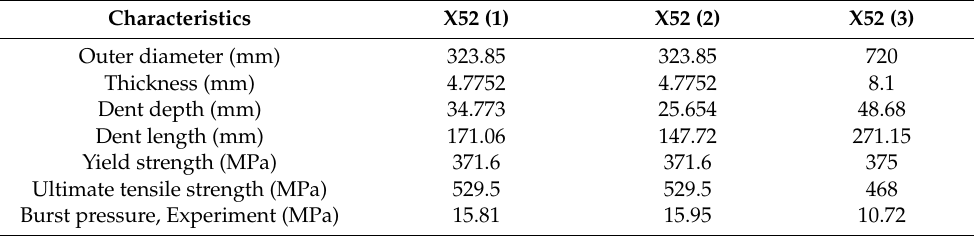
Table A5. Validation information from the experimental result of the hemispherical dent